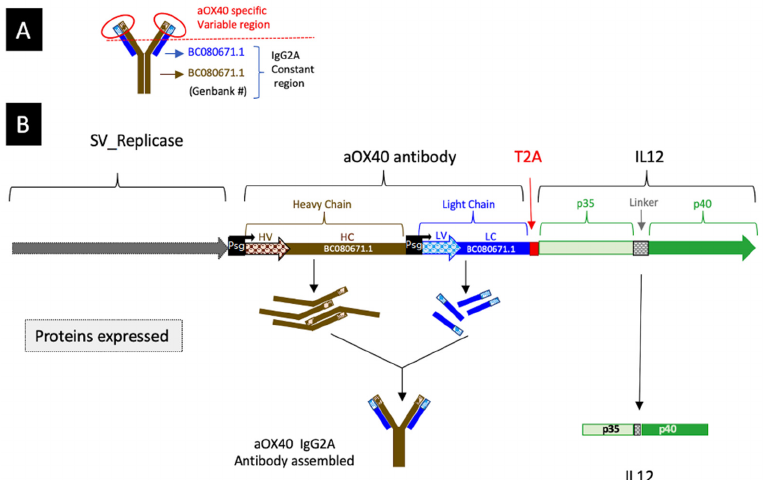
Figure 1. SV Replicon SV.IgGOX-40.IL-12. ( A ) Anti-OX40 IgG 2A design. ( B ) SV.IgGOX40.IL-12 linear map. The ⍺ OX40 heavy chain is expressed from one SV subgenomic promoter (Psg). The ⍺ OX40 light chain and IL12 cytokine are expressed from a second SV subgenomic promoter (Psg). To produce IL-12, a T2A peptide sequence from Picornaviridae virus family was inserted at the 3 ′ end of ⍺ OX40 light chain after removing the stop codon and before the IL-12 sequence.